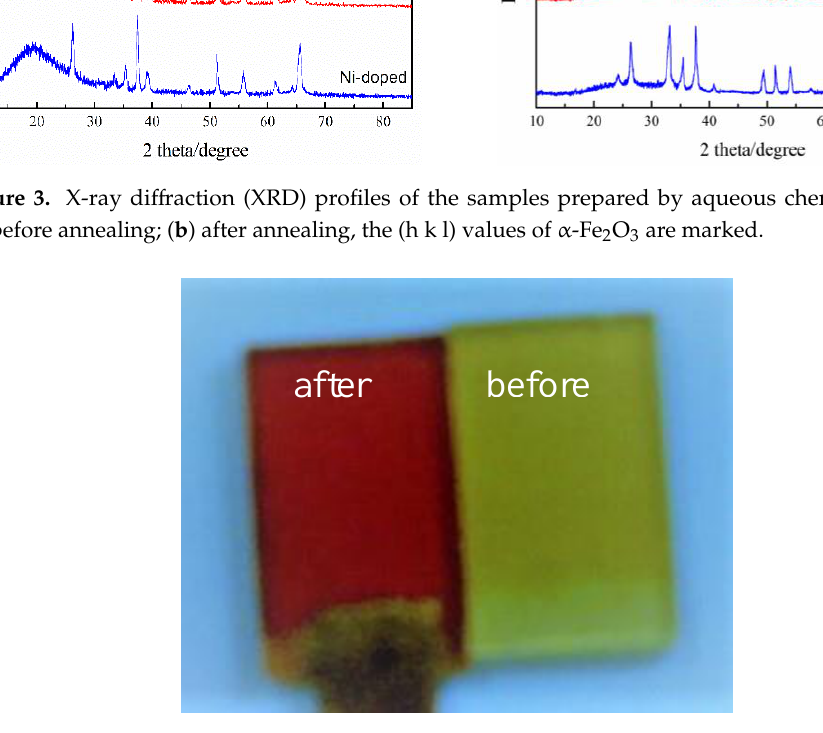
Figure 4. Photograph of the samples obtained from aqueous chemical growth before and after annealing.